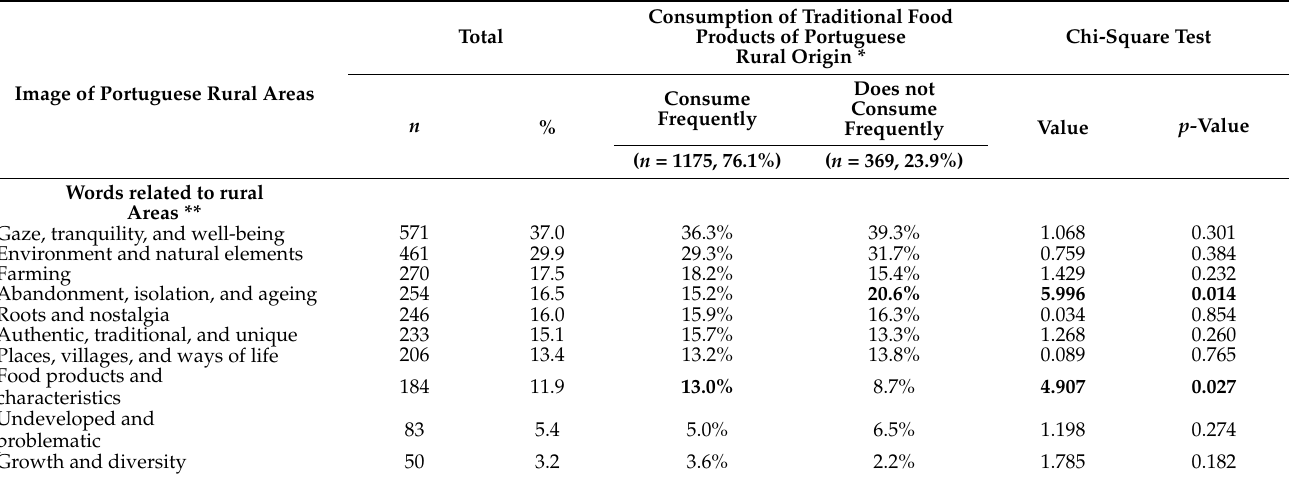
Table 4. Consumers’ images of Portuguese rural